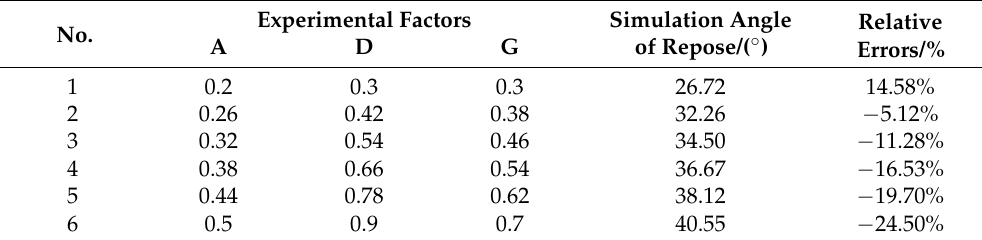
Table 5. The arrangements and results of significant influencing factors (Poisson’s ratio of FJF A , static friction coefficient of FJF–FJF D , and static friction coefficient of FJF–steel plate G ) with a steepest ascent search experiment. No.